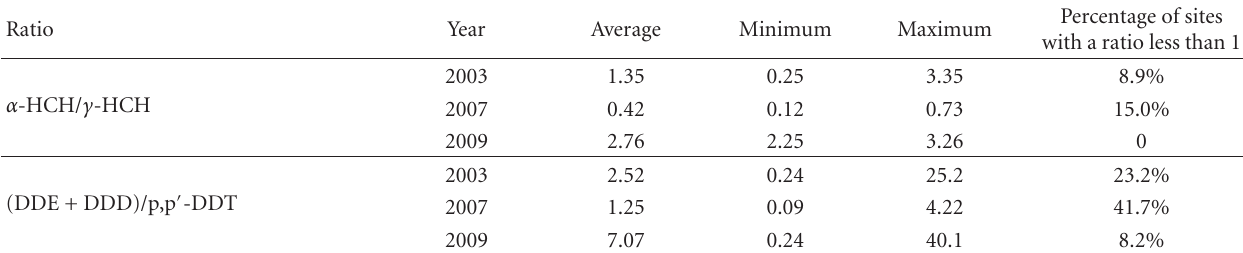
Table 2: Composition of HCH and DDT in soil samples in 2003, 2007, and 2009.